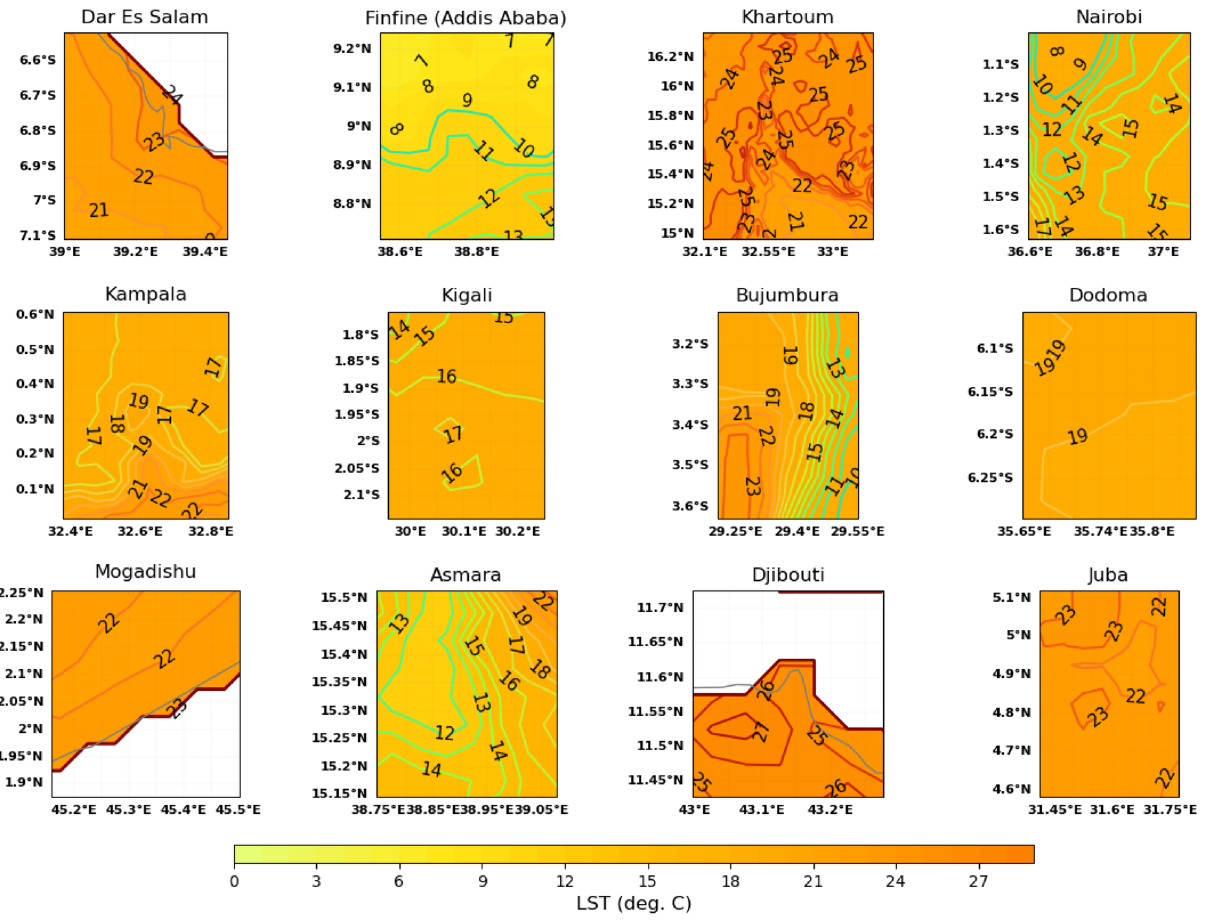
Figure 5. Night time land surface temperature around the capital cities in the greater horn Africa.